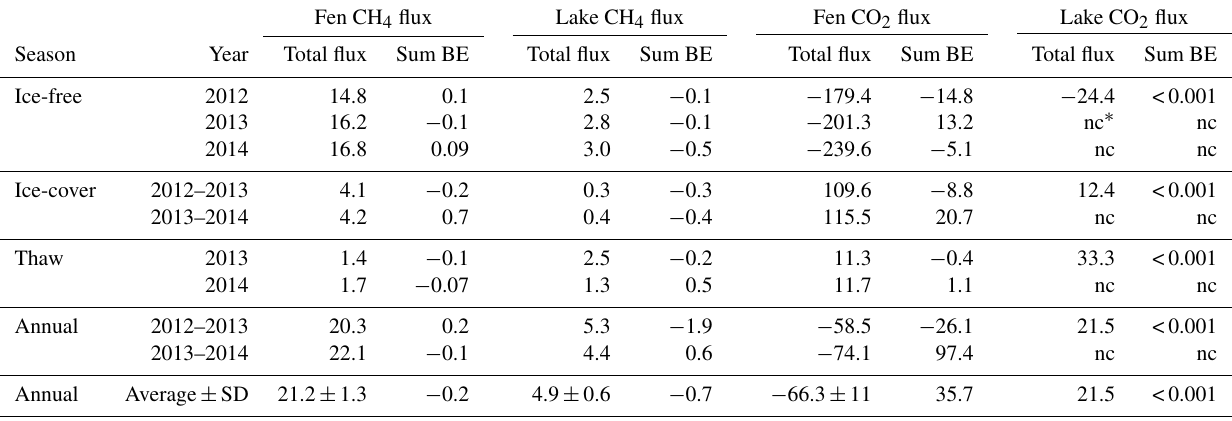
Table 3. Seasonal and annual sums of CO 2 and CH 4 fluxes after gap filling, in gCm − 2 yr − 1 . Sum BE is the bias due to the gap filling model (Eq. 1), scaled to annual flux units and multiplied by the number of gaps in the flux dataset over the season or year. The sum of CO 2 fluxes from the lake is only reported for the first year.